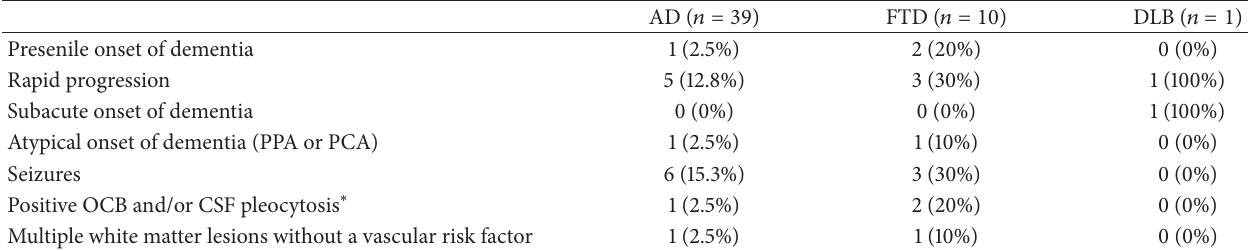
Table 1: Dementia patients with atypical features that were presumed to be suggestive of autoimmune